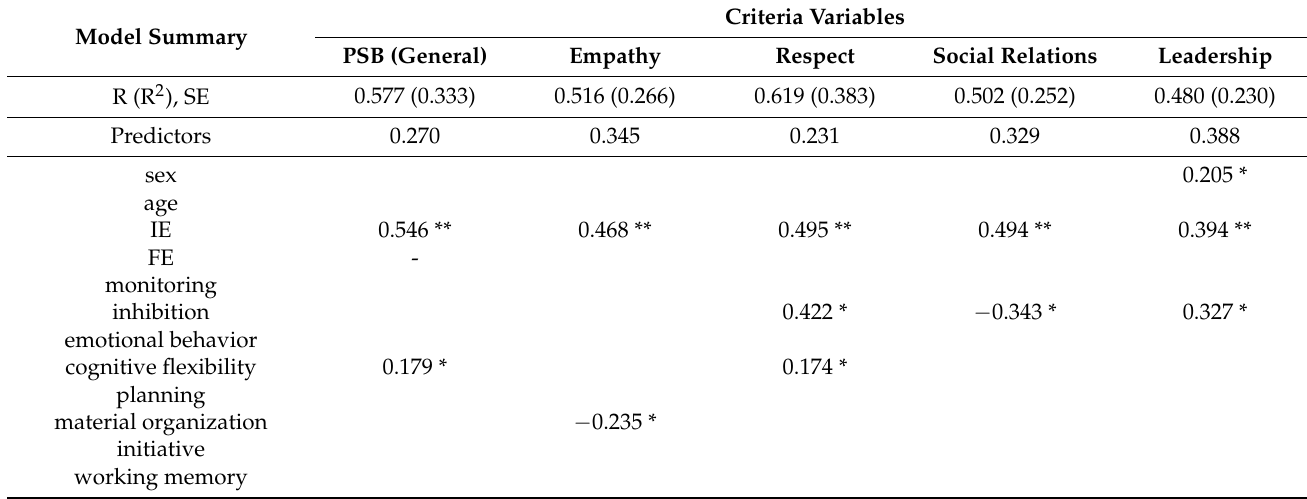
Table 3. Standardized regression coefficients corresponding to the significant predictors of the five criterion variables. Model